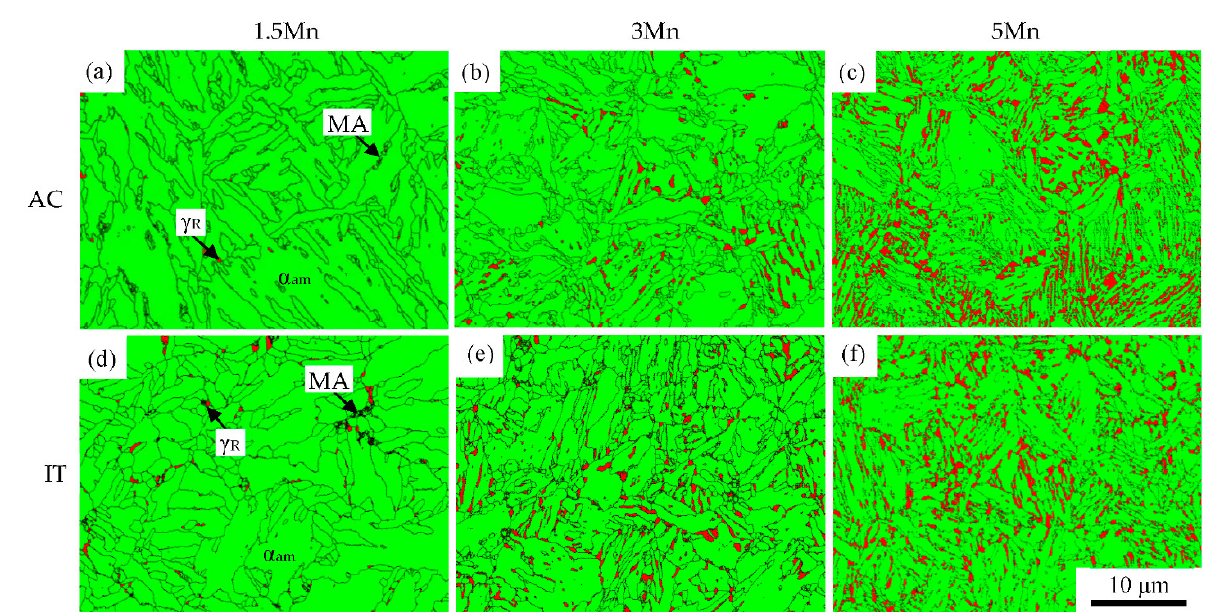
Figure 3. Phase maps of SEM-EBSD in the 1.5 Mn, 3 Mn and 5 Mn steels subjected to ( a – c ) the AC and ( d – f ) IT processes. Green and red phases denote annealed martensite ( α am ) and reverted austenite ( γ R ), respectively. “MA” represents the martensite-austenite phase. Average lath sizes of annealed martensite in the 1.5 Mn, 3 Mn, and 5 Mn steels subjected to the AC and IT processes are 4.3 μm, 3.1 μm, and 2.4 μm, respectively. Table 2. Reverted austenite characteristics, tensile properties at 25 ◦ C and impact toughness properties of the 1.5 Mn, 3 Mn, and 5 Mn steels subjected to the AC and IT